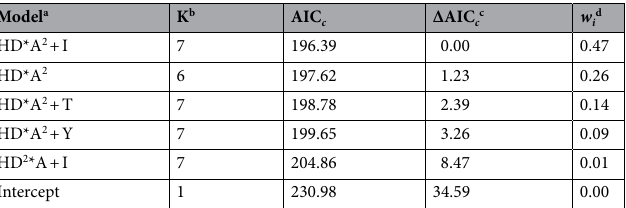
Table 1. The five most-supported models plus the intercept-only model from a set of 105 candidate models estimating daily survival rates of Dunlin chicks near Utqiaġvik, Alaska, 2008–2009. a Variables in the models are hatch date as a linear (HD) or quadratic term (HD 2 ), chick age as a linear (A) or quadratic term (A 2 ), daily invertebrate biomass (I), daily average air temperature (T), and year (Y). When a quadratic effect was included in a model, we also included the linear effect. b No. of parameters. c Difference between models